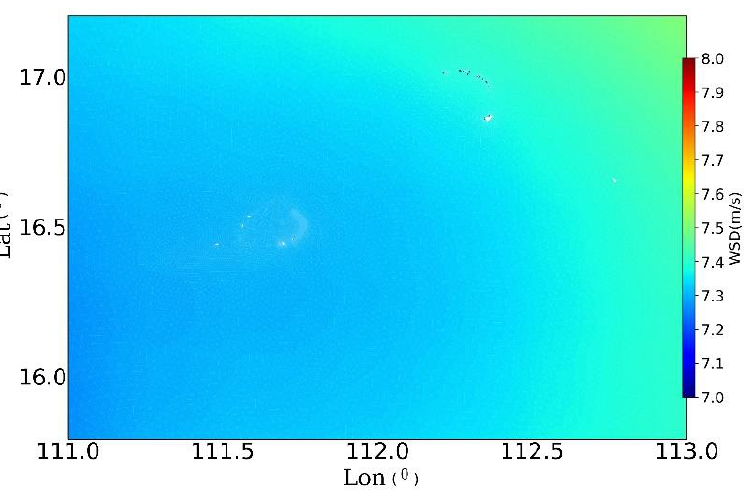
Figure 6. Hourly averaged wind speed (WSD) over the Xisha Islands.